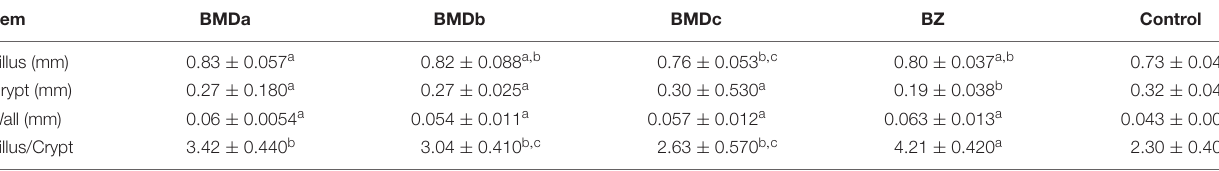
TABLE 1 | Comparison of BMD based on the morphology of the duodenum in weaned rabbits.